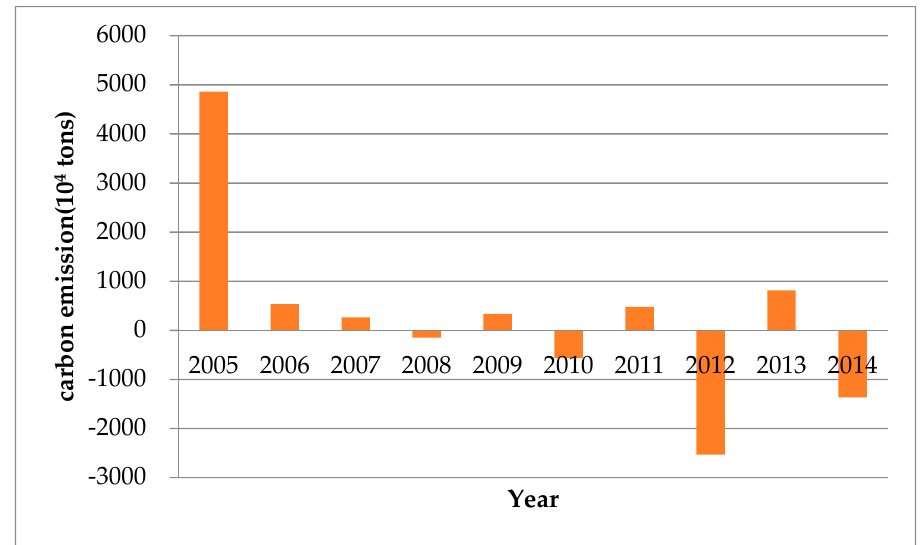
Figure 8. The effect of energy structure on carbon emissions in China during 2005–2014.